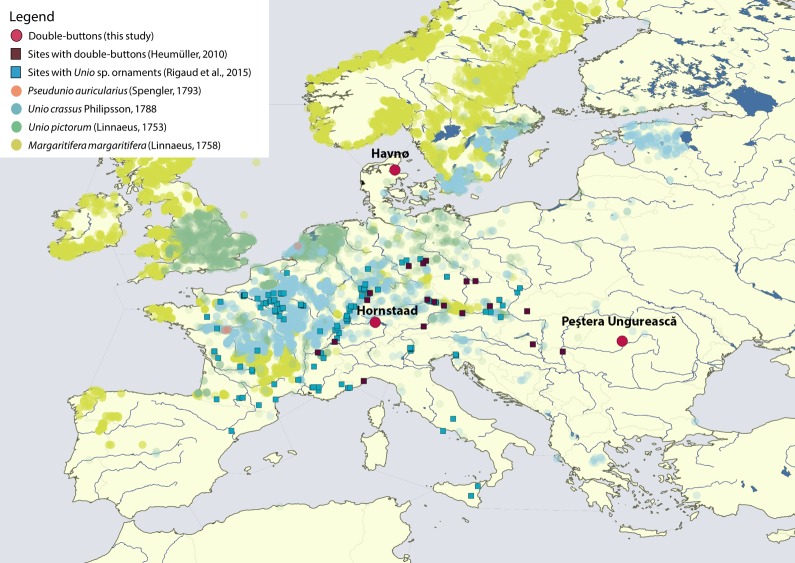
Map displaying the location of Havnø, Hornstaad-Hörnle IA and Peştera Ungurească, together with other archaeological sites from which double-buttons (Heumüller, 2012) and a variety of ornaments made with Unio sp. shells (Rigaud et al., 2015) have been reported.